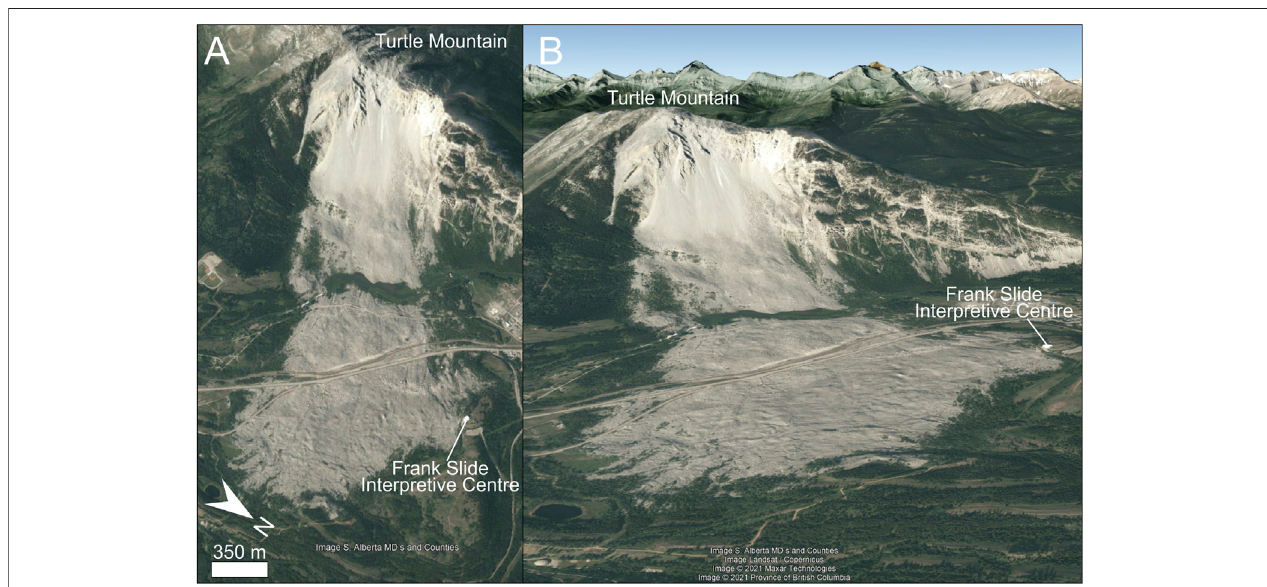
FIGURE 3 | Aerial (A) and oblique (B) view of the Frank slide, which detached from Turtle Mountain on 29th April 1903; today the Frank Slide Interpretive Centre is located at the edge of the slide deposits. Images are from Google Earth.